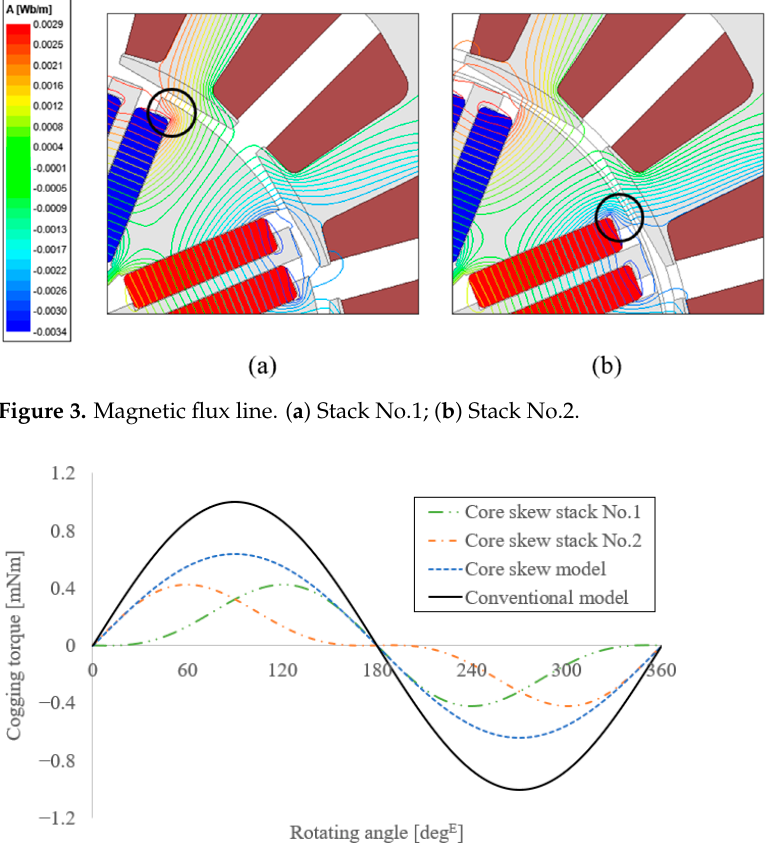
Figure 4. Example of reduction of cogging torque through core skew.